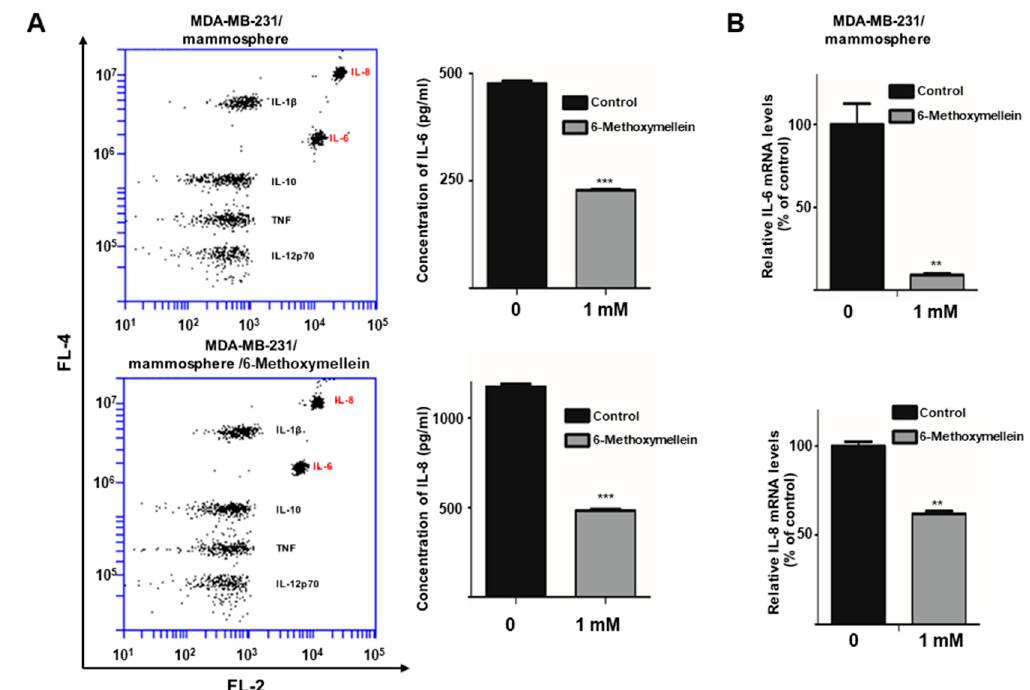
Figure 7. 6-Methoxymellein suppresses the secretion and transcription of IL-6 and IL-8. ( A ) The CBA Human Inflammatory Cytokine Assay Kit was used to assay the secretion of cytokines in mammosphere culture media treated with 6-methoxymellein or DMSO. ( B ) Transcript levels of the IL-6 and IL-8 genes were assessed in 6-methoxymellein-treated mammospheres using specific RT-qPCR primers. Our data are represented as the mean ± SD. ** p < 0.05 and *** p < 0.01 versus the control group.